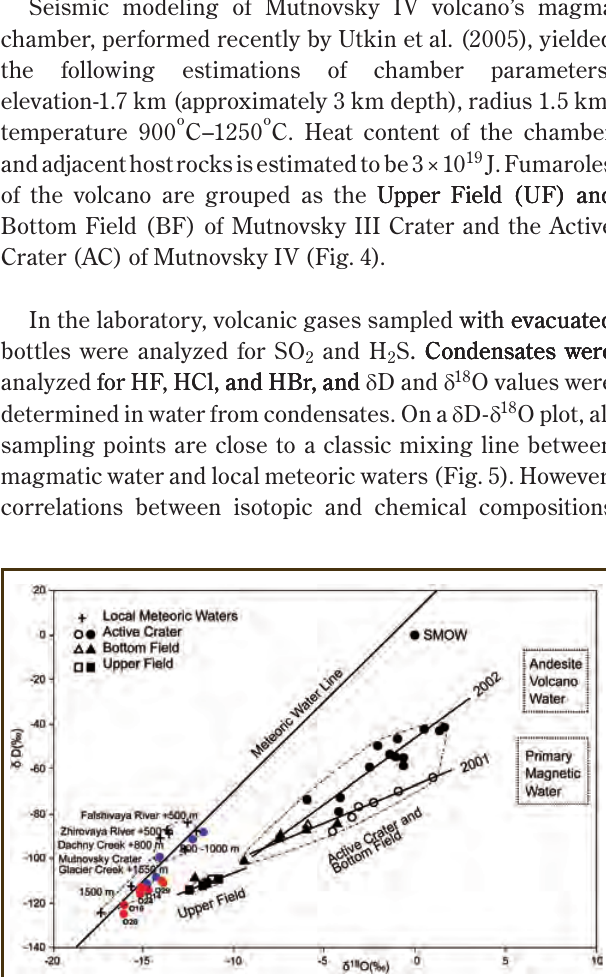
(cid:35)(cid:80)(cid:83)(cid:70)(cid:73)(cid:80)(cid:77)(cid:70)(cid:84)(cid:74)(cid:79)(cid:85)(cid:83)(cid:86)(cid:84)(cid:74)(cid:80)(cid:79)(cid:84) Figure 4. Cross-section and conceptual geothermal/hydrogeological model of the Mutnovsky volcano (Mutnovsky geothermal field system). MSDP1: potential borehole for the Mutnovsky Scientific Drilling Program. Upflow rates estimated based on numerical models are 50–60 kg s -1 with enthalpies of 1270–1390 kJ kg -1 . (by A. Kiryukhin and J. Eichelberger)